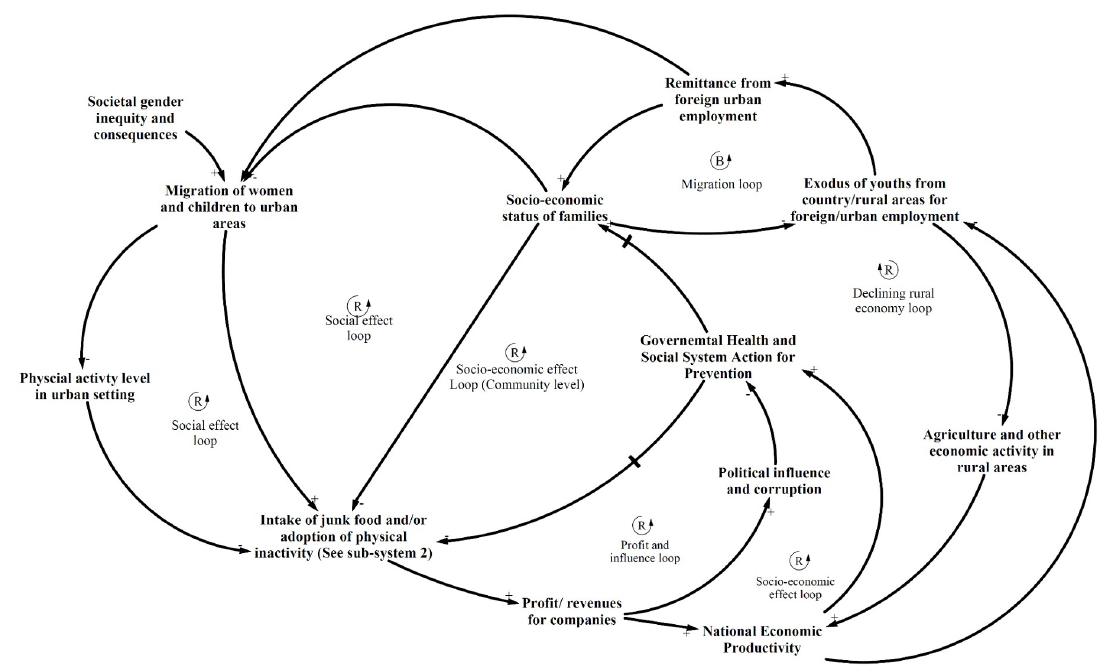
Fig 5. Socio-economic influence sub-system showing the interaction of socio-economic status, other sub-systems for dietary and physical activity practices and NCDs.